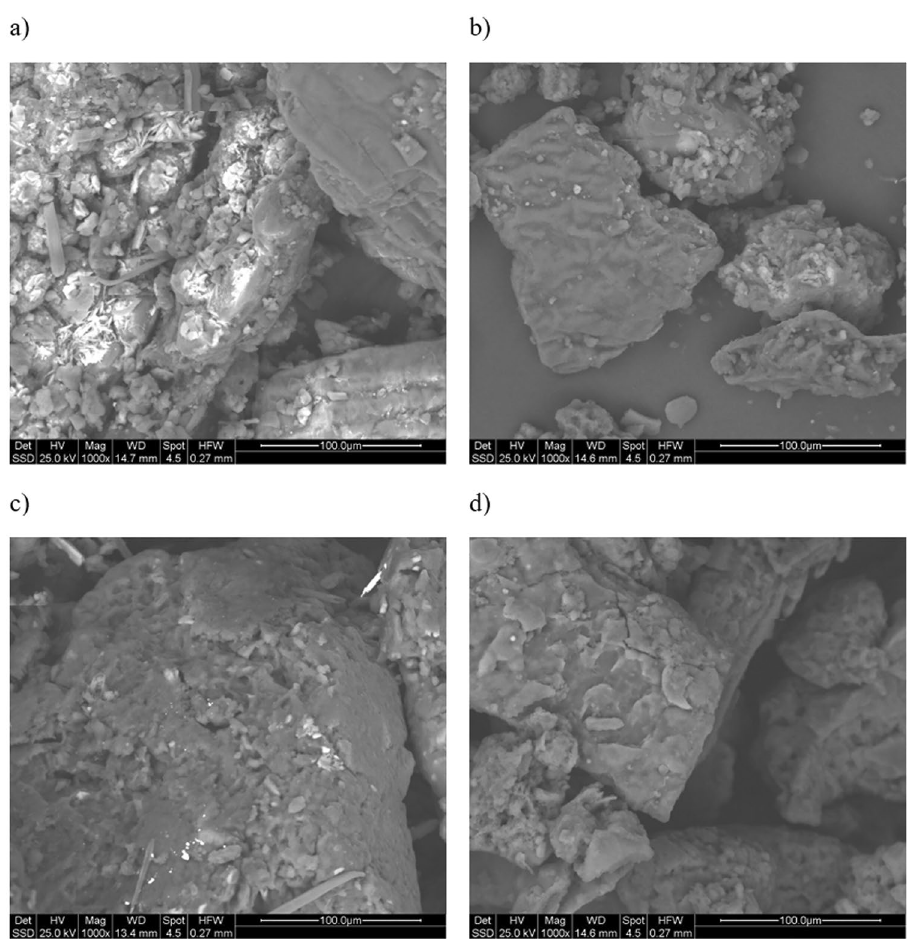
Figure 5. ESEM micrograph of the backscattered electrons at 1000X: ( a ) S1 > 250, ( b ) S1 < 250, ( c ) S2 > 250, ( d ) S2 <